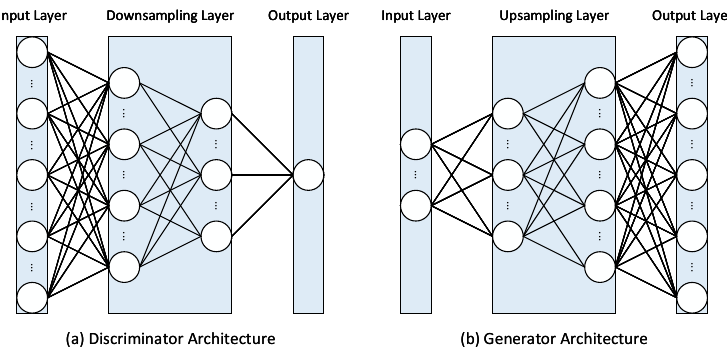
Figure 7. Illustration of used GAN model